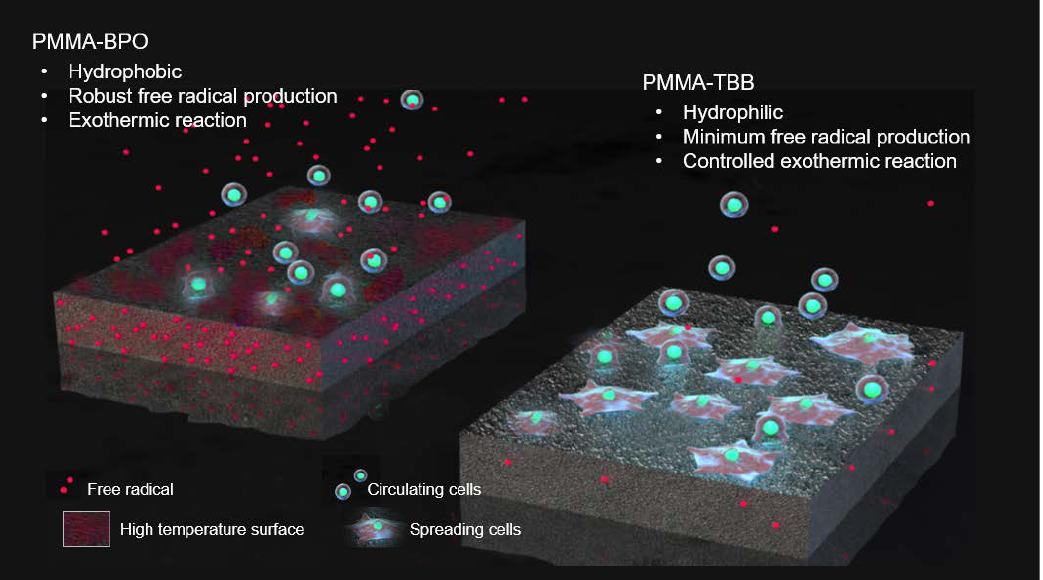
Figure 8. Schematic diagram of the unique physicochemical property of polymethyl methacrylate- tri-n-butyl borane (PMMA-TBB), characterized by a hydrophilic surface, minimum free radical production, and controlled exothermic reaction during polymerization, which enhanced cell attachment and subsequent osteogenic function.